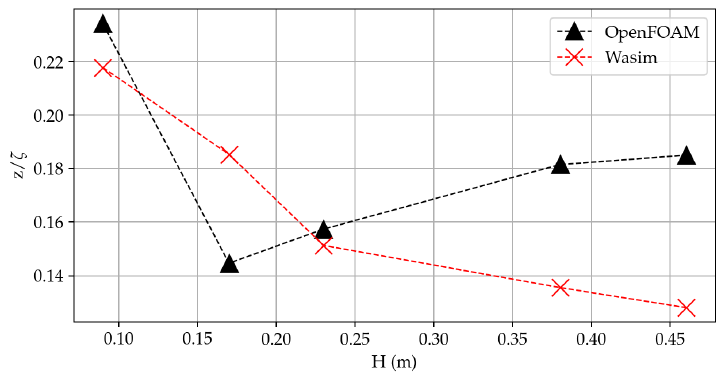
Figure 16. The nondimensional amplitude of heave response for the 6750 TEU containership.